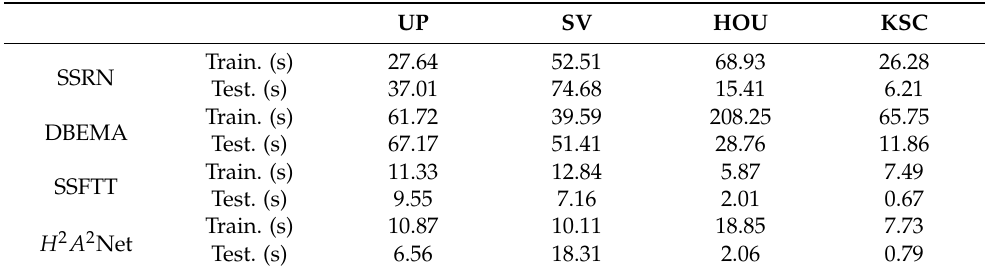
Table 10. Training and testing time of different methods on four